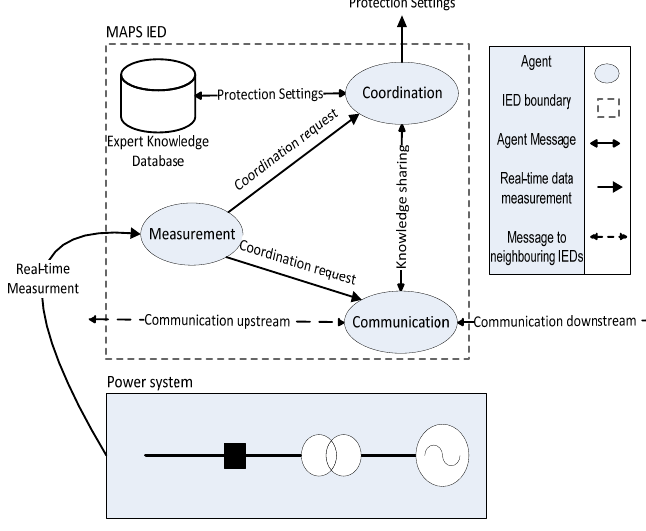
Figure 6. Use case representing interactions in the proposed MAPS.